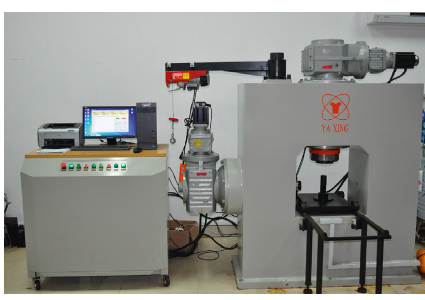
Figure 2: YSSZ-500A Rock Biaxial